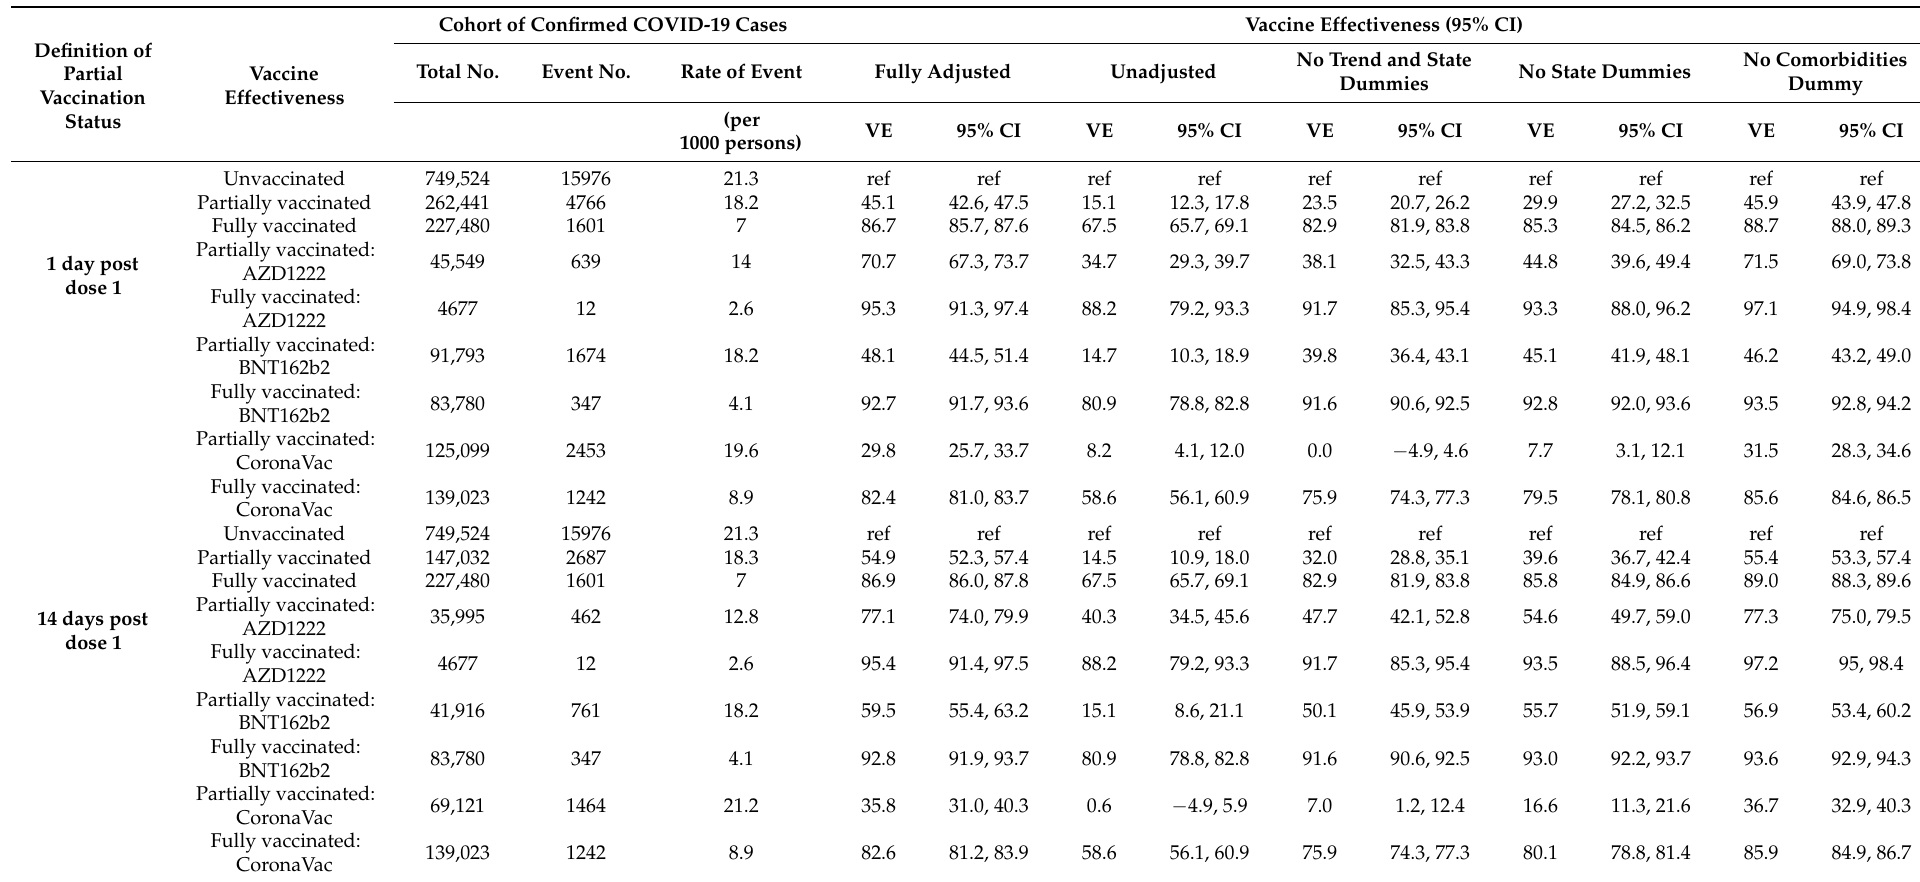
Table A7. Fully adjusted, partially adjusted, and unadjusted vaccine effectiveness in preventing death among COVID-19 cases by definitions of partial vaccination status. Definition of